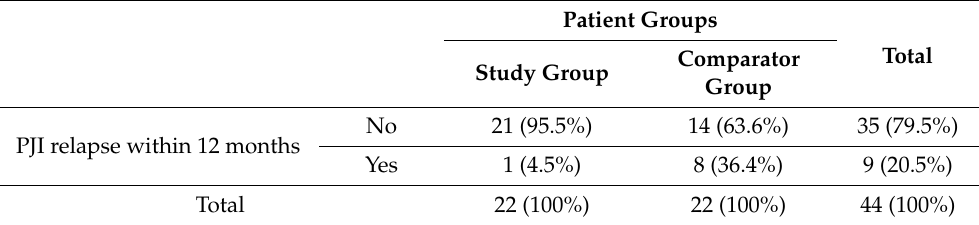
Table 3. Statistics for 12-month PJI relapse rate (primary endpoint, PP